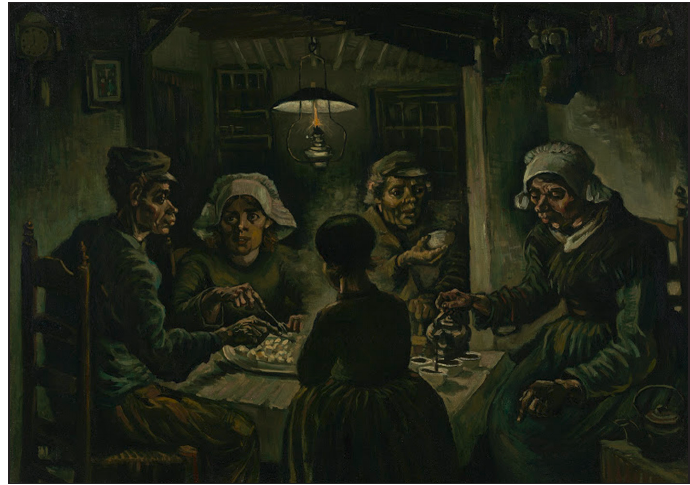
Fig. 3 : Vincent Van Gogh, The Potato Eaters , 1885, oil on canvas, 82 × 114 cm. Credit: Van Gogh Museum, Amsterdam (Vincent van Gogh